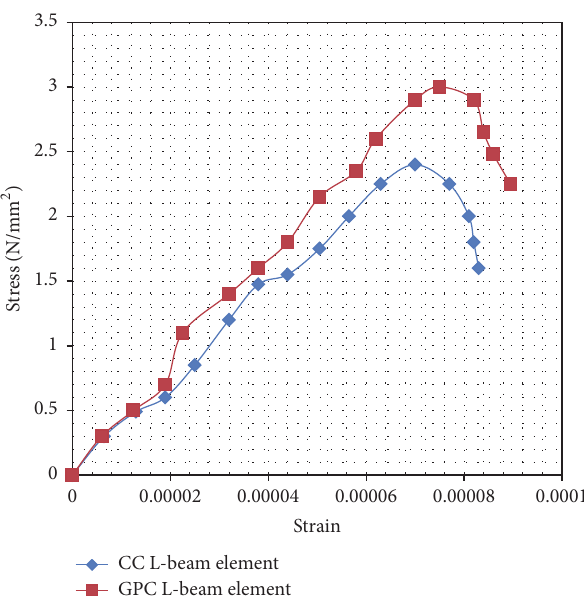
Figure 7: Stress-strain curve for L-beam.